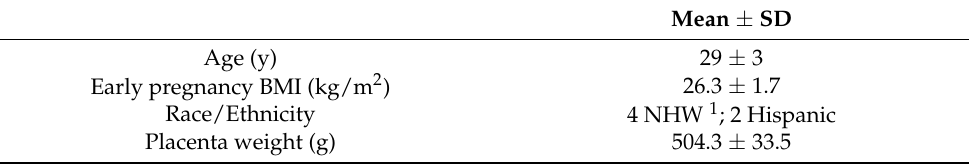
Table A1. Maternal Demographics.